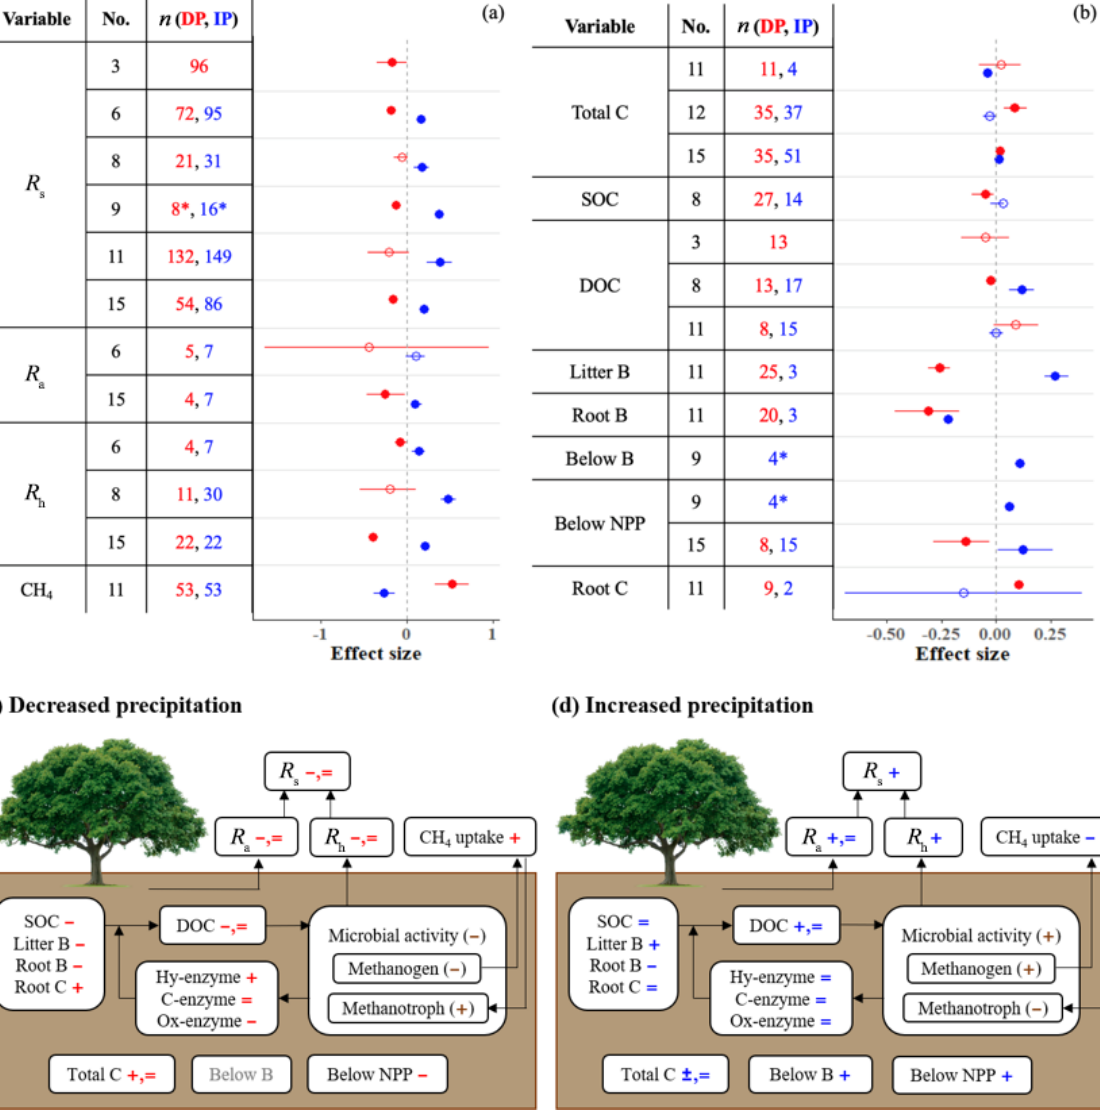
Figure 1. (a,b) Effect sizes for (a) soil respiration and methane uptake and (b) carbon and belowground biomass variables with respect to decreased (red) and increased (blue) precipitation. Filled points represent significant effect sizes (95% CI not overlapping 0), and open points represent nonsignificant effect sizes. Variable names correspond to Table 2. No. is meta-analysis number as listed in Tables 1 and 2. The sample size is indicated by n . Asterisks indicate missing 95% CIs. (c,d) The effects of (c) decreased precipitation and (d) increased precipitation on the soil carbon cycle. Negative, positive, and nonsignificant effects are represented by − , + , and = , respectively. Red and blue represent variables found in one or more meta-analyses. Brown symbols in parentheses represent the variables that no meta-analyses quantified; in these cases, we estimated the effects based on our review of empirical studies in Sect.